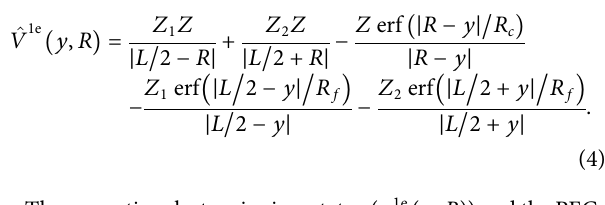
Frontiers in Chemistry |